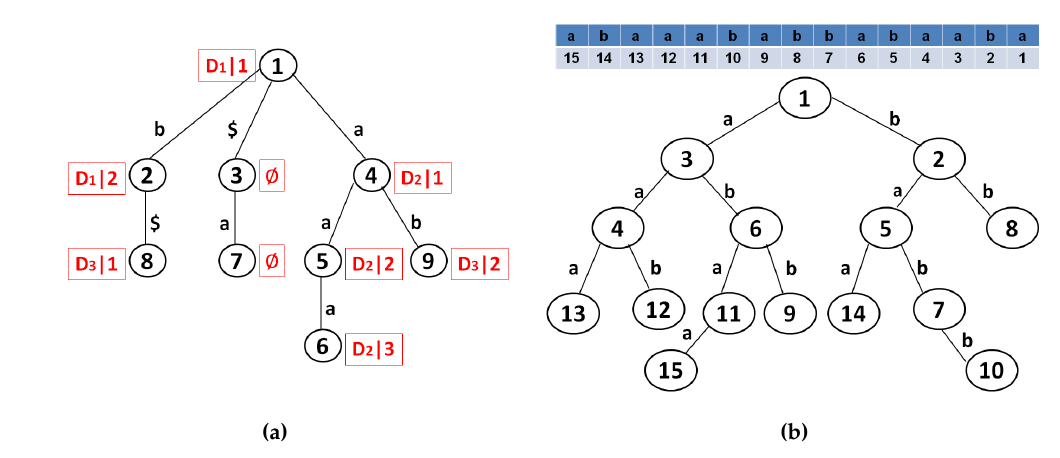
Figure 3. An example of the position heap tree. ( a ) Constructed from the text “ab$aaa$bb”’ extracted from documents ( D 1 , D 2 , D 3 ) ; ( b ) constructed from the text